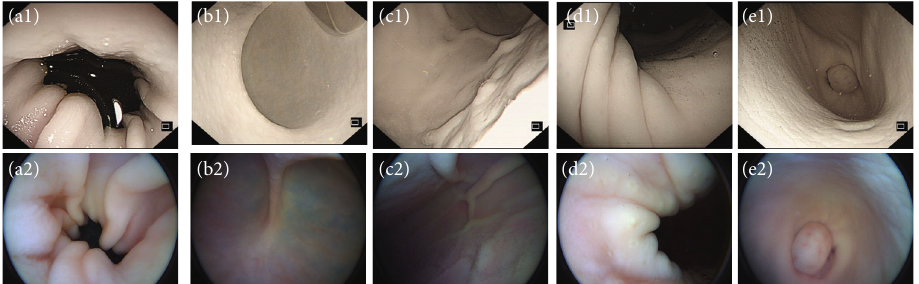
Figure 4: Images taken by conventional gastroscopy and the magnetically controlled cable capsule endoscopy (MCCCE) system in the excised porcine stomach model. (a1 – e1): Cardia, fundus, gastric body, gastric angle, antrum, and pylorus detected by conventional gastroscopy. (a2 – e2): The same landmarks detected by